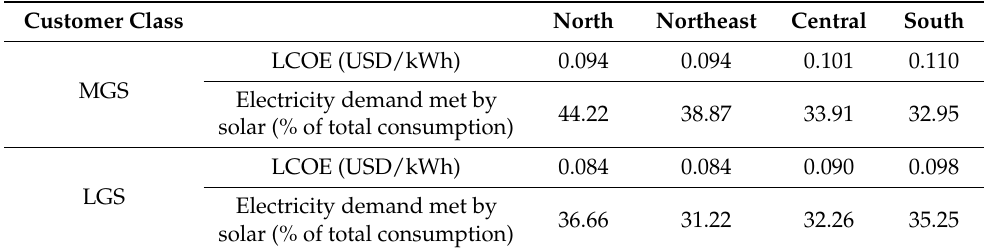
Table 4. Average LCOE and level of PV generation supplied to load by region for MGS and LGS customers.